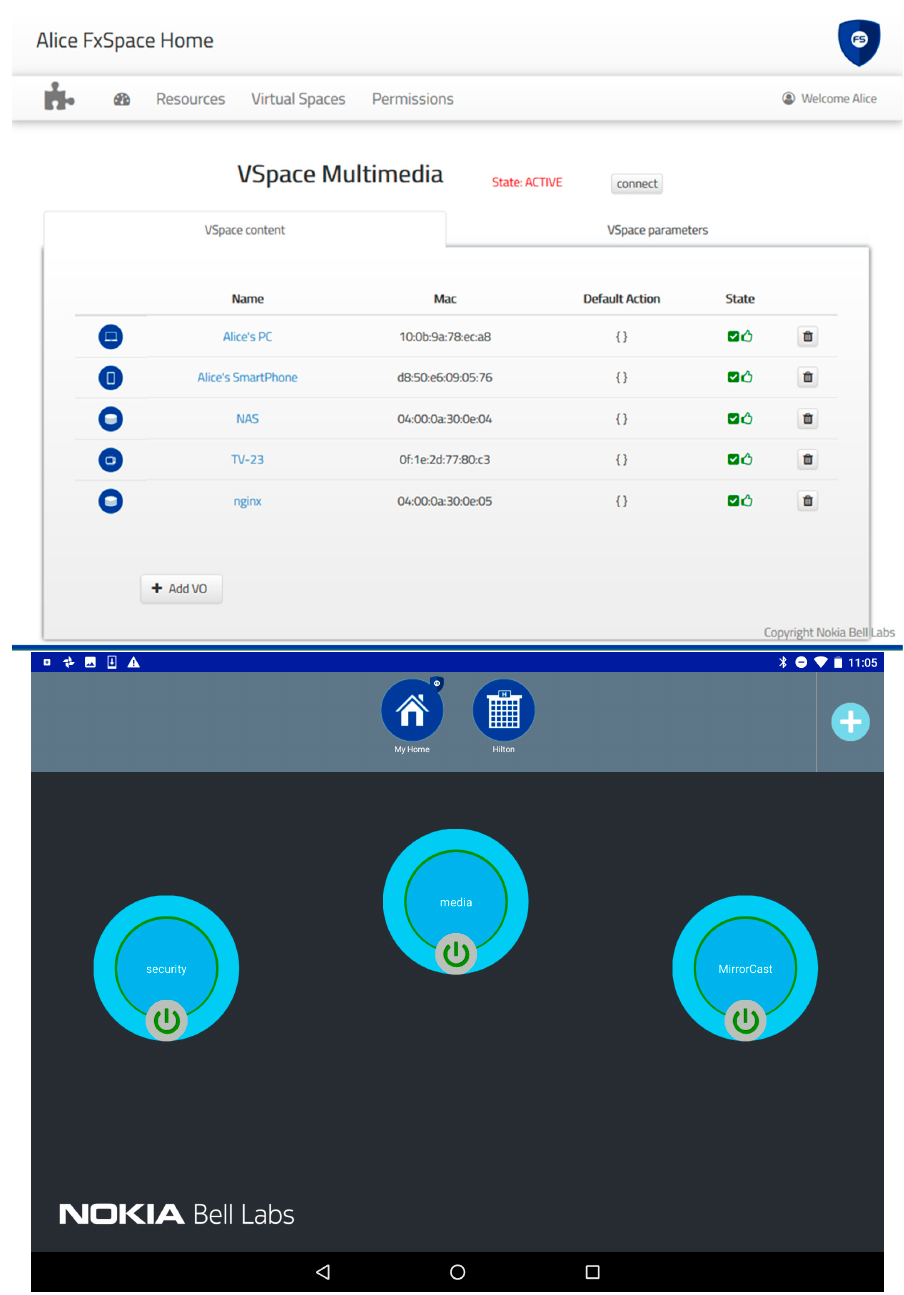
Figure 10. Screenshot of the MajordHome web interface showing the composition of a “Multimedia vSpace” ( top ) and the Android UI ( bottom ).